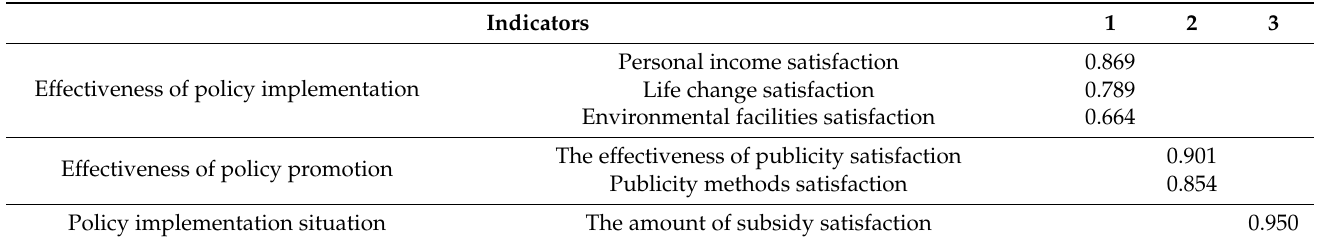
Table 6. Rotation load factor array.